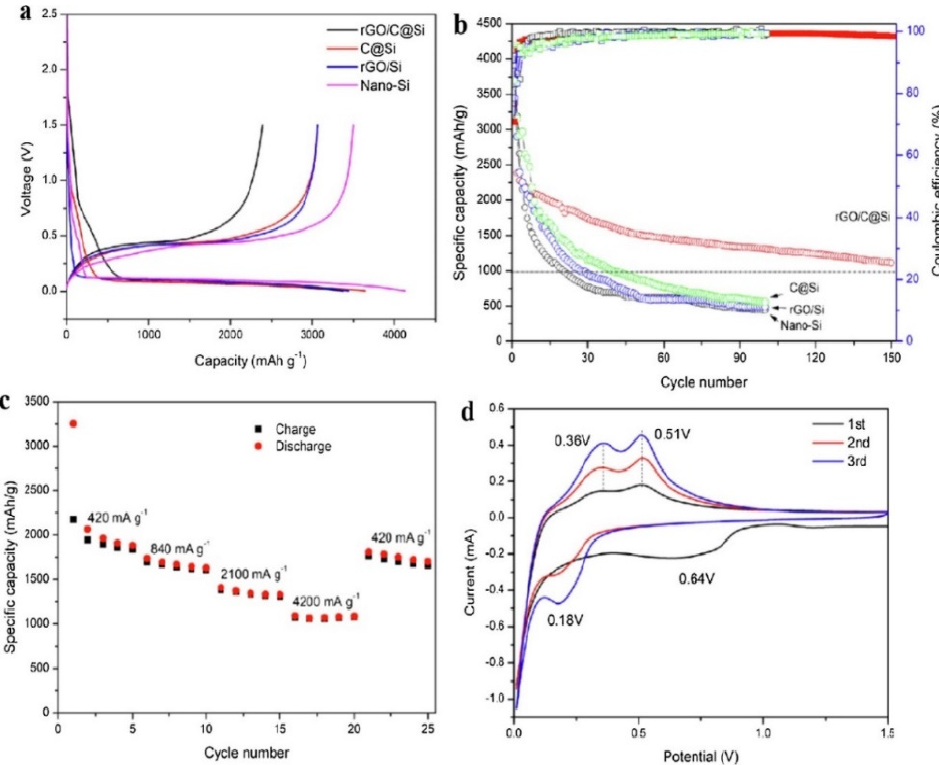
Figure 9. Electrochemical evaluations of fabricated anodes. ( a ) Initial charge/discharge of